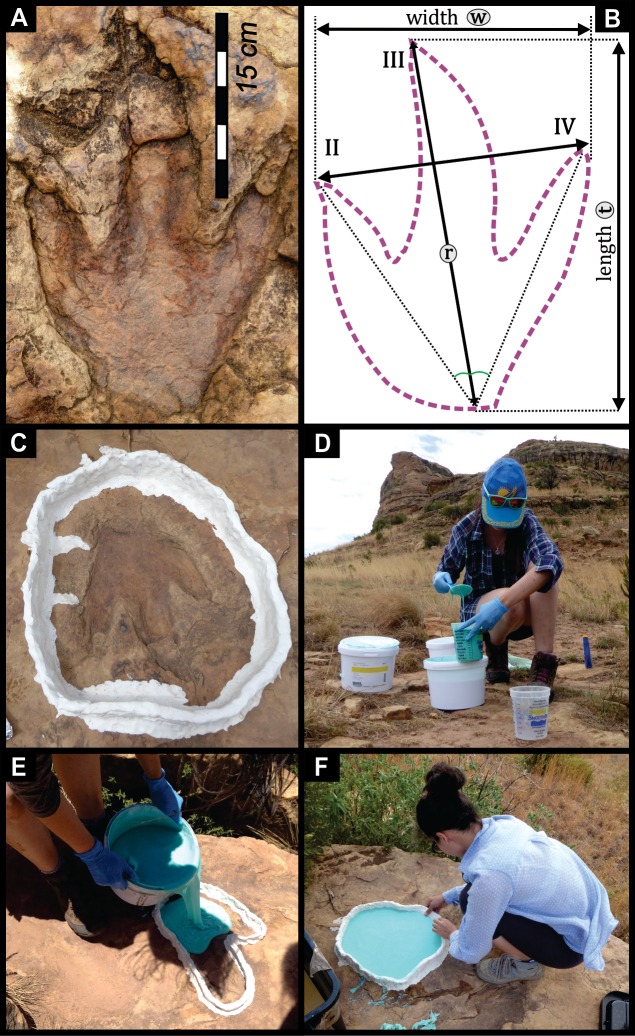
Track morphology (A) and corresponding outline drawing (B) of a Mafube track showing the placement of measurements used in this study. Numbers II–IV are referencing the imprints of the three digits of a tridactyl theropod dinosaur foot; interdigit angles (marked with green arches) are also referred to as divarication angles; ‘t’ is the track length; ‘w’ is the track width; ‘r’ is the length of rear of phalangeal part of foot (cf. Olsen, Smith & McDonald, 1998). Footprint casting process documented in photographs. (C) A cleaned and dried track has been surrounded with a retaining wall of non-curing modelling clay. (D) Decanting Part A and Part B of the silicone rubber into two measuring containers in equal amounts. (E) Pouring the silicone rubber into a track. (F) Removing the non-curing modelling clay to free-up the cured rubber cast of the track.